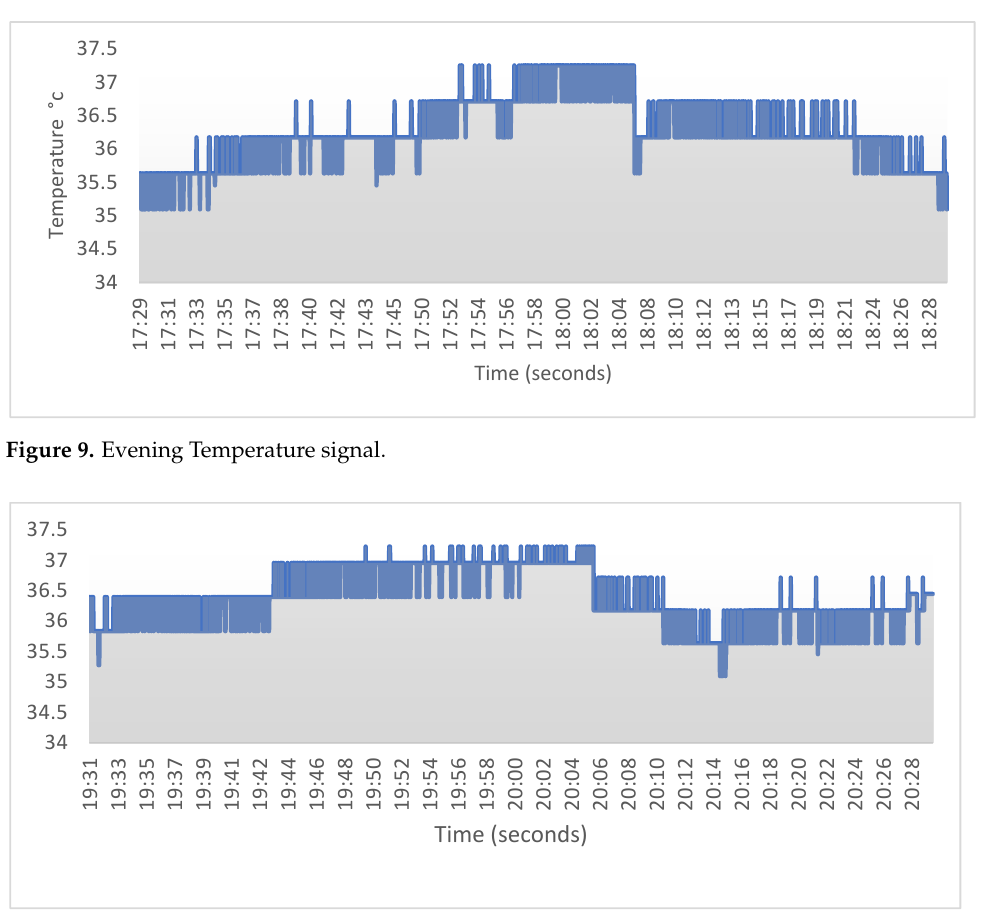
Figure 10. Night Temperature signal. Table 4. Average Body Temperature of a day (High-Accuracy Touch Temperature Sensor).